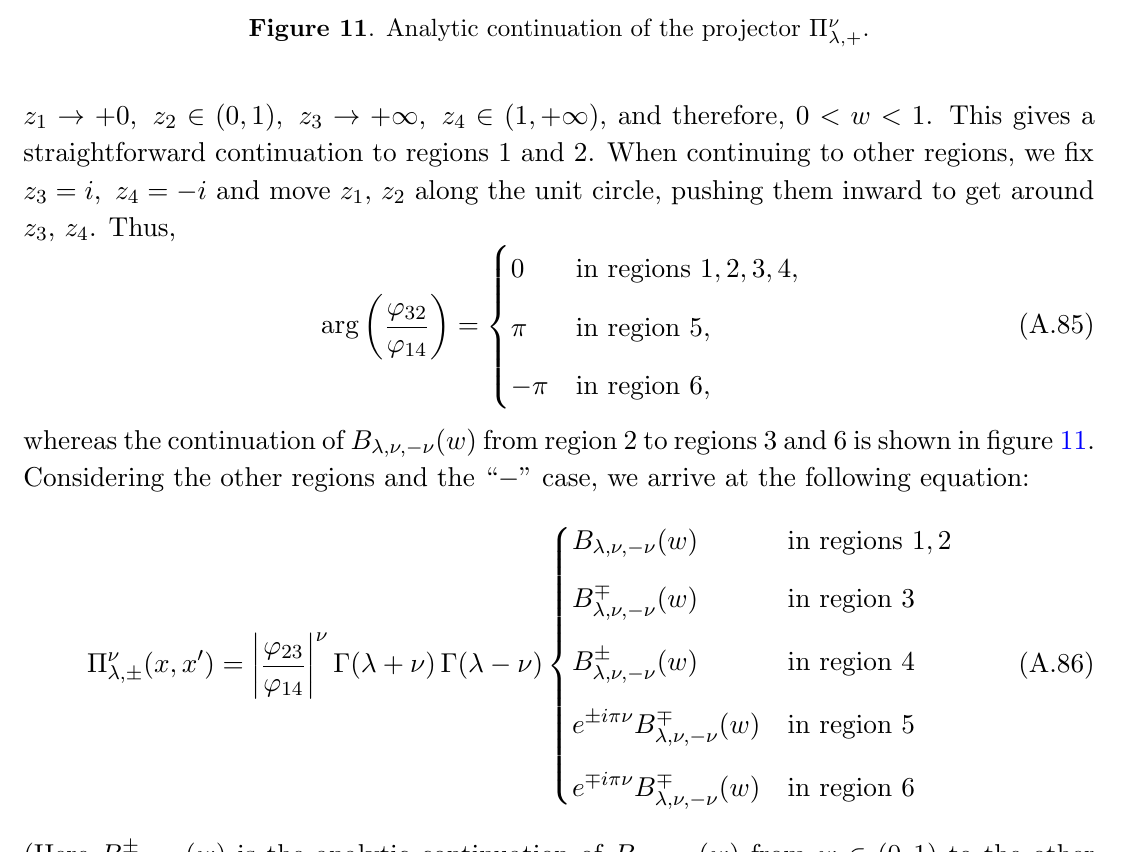
Figure 11 . Analytic continuation of the projector (cid:5) (cid:23)